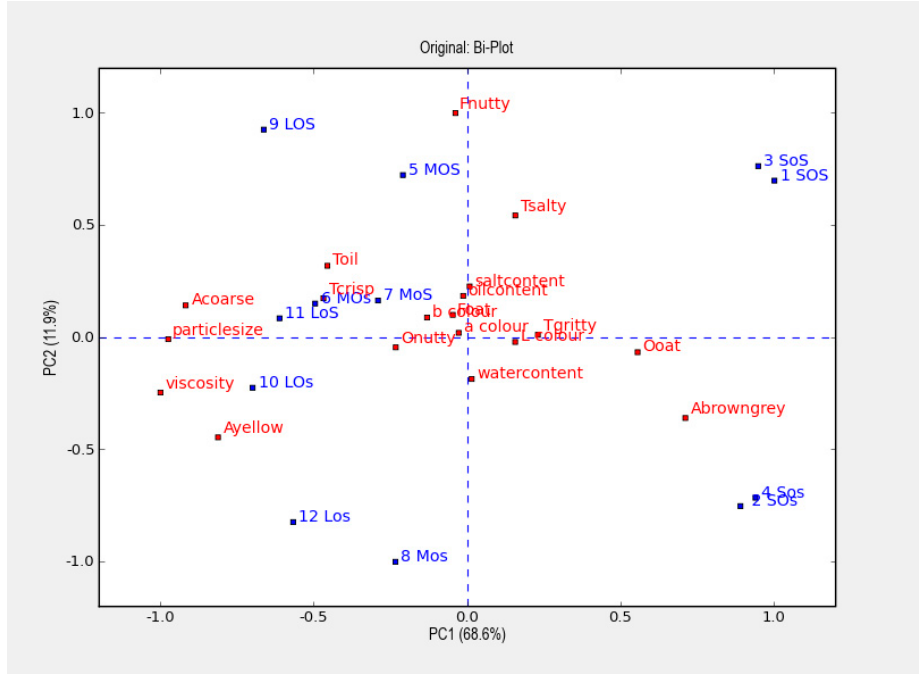
Figure 2. Principal component analysis (PCA) plot giving an overview of all results, visualizing the impact of the design parameters in the factorial design. Table 7. Pearson correlation coe ffi cients ≥ 0.7 are given in the